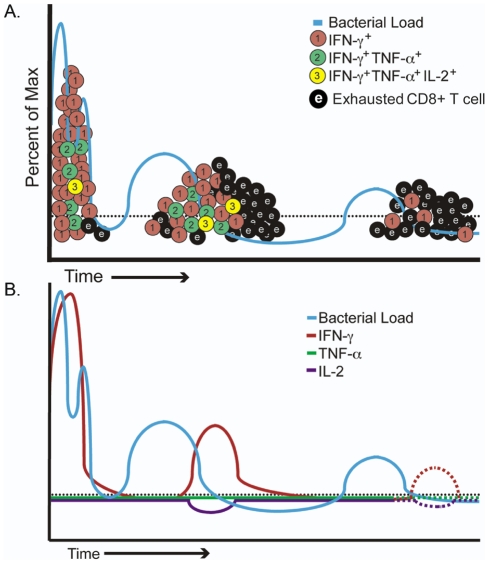
Models of CD8+ T cell function during chronic reactivating brucellosis.A) Model of CD8+ T cell functional response during chronic infection with Brucella melitensis. Initially, CD8+ T cells respond to B. melitensis and clonally expand with many clones producing one cytokine such as IFNγ, while fewer clones produce two or three cytokines. With continuing waves of Brucella release from infected cells, CD8+ T cell expansion is reduced with fewer and fewer cells producing multiple cytokines and a larger pool of cells producing no detectable cytokines representing an exhausted phenotype. Adapted from [87]. B) Model of CD8+ T cell expression of individual cytokines. Black dotted line represents background level of expression in uninfected mice. As waves of Brucella are released from infected cells, cytokine expression occurs with reduction of IFNγ and no IL-2 or TNFα expression.